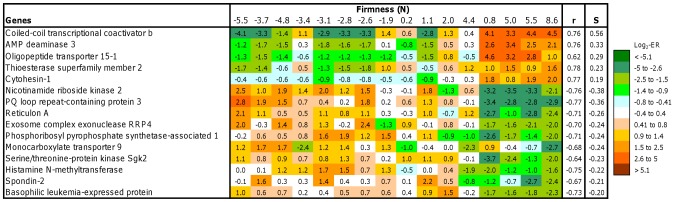
Expression of individual genes (candidate markers) correlating with firmness of salmon skeletal muscle (n = 16 fish).Data are log2-ER and are highlighted with a color key. r =  Pearson correlation coefficient, S =  coefficient of linear regression (S – slope).